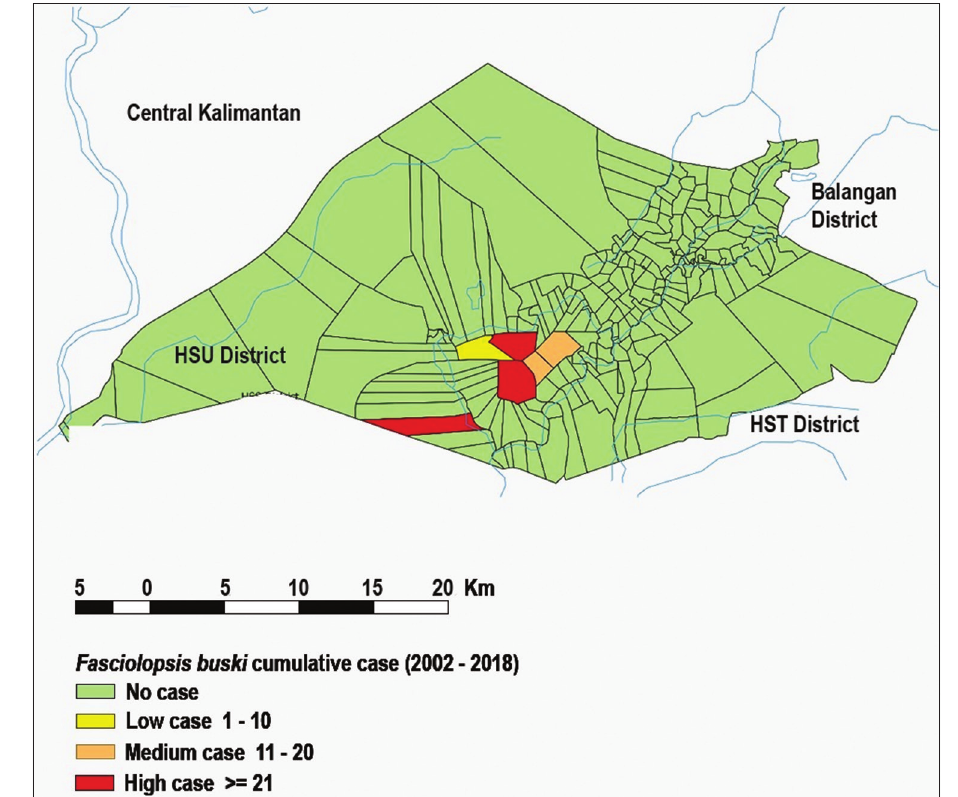
Figure-5: Cumulative cases of Fasciolopsis buski from 2002 to 2018 [Source: QGIS Nodebo